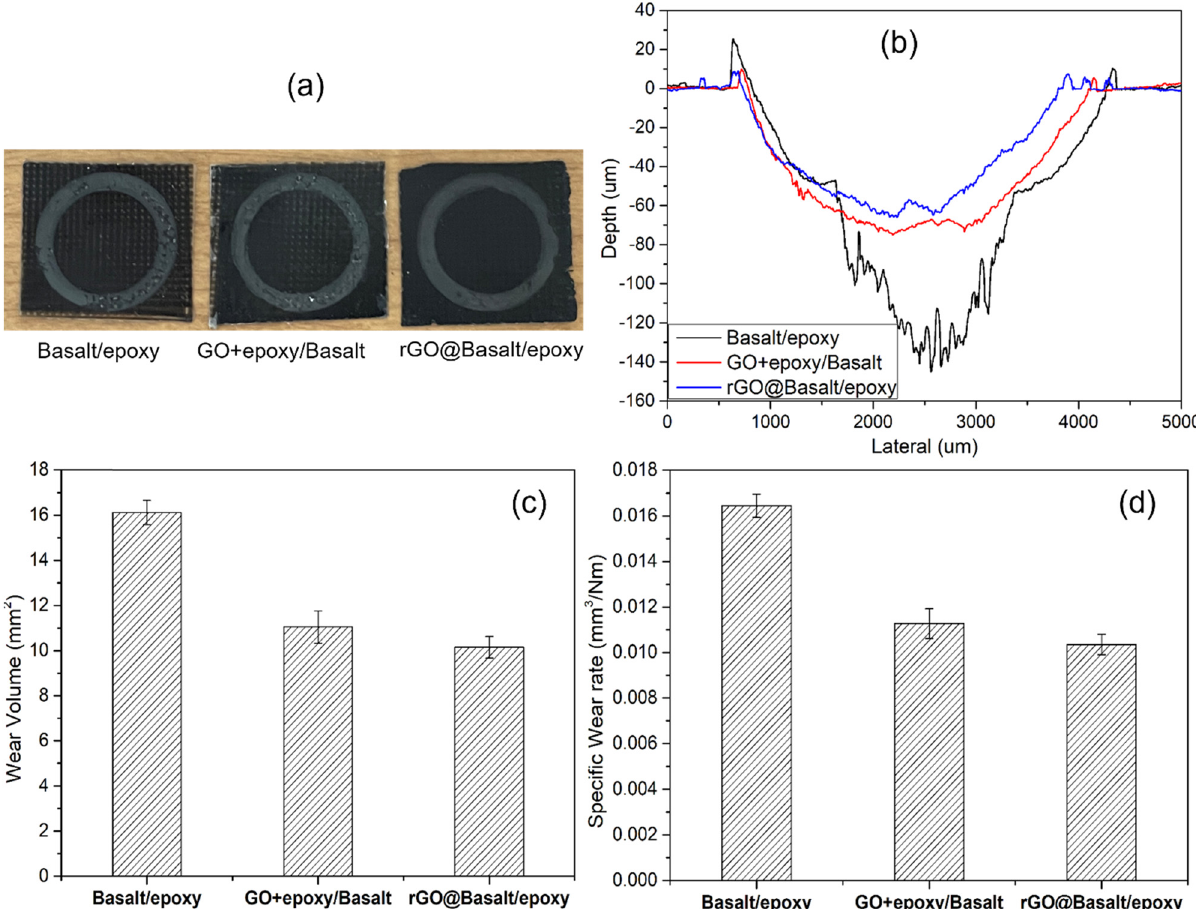
Figure 8: Comparison of ( a ) full wear track, ( b ) cross - section of wear track, ( c ) wear volume, and ( d ) speci fi c wear rate of basalt/epoxy, GO + epoxy/basalt, and rGO@Basalt/epoxy composites wear